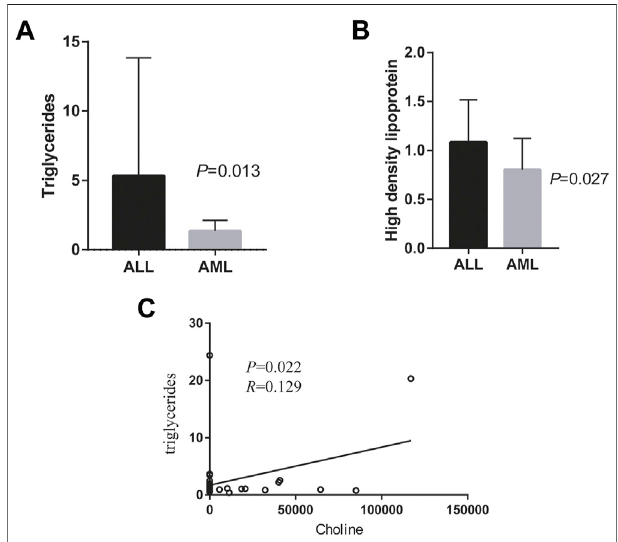
FIGURE 6 | Comparison of clinical data and correlation analysis of metabolites between different leukemia groups. (A) : Comparison of High density lipoprotein between acute lymphoblastic leukemia and acute myeloid leukemia; (B) : Comparison of High density lipoprotein between acute lymphoblastic leukemia and acute myeloid leukemia; (C) : Comparison of High density lipoprotein and choline.